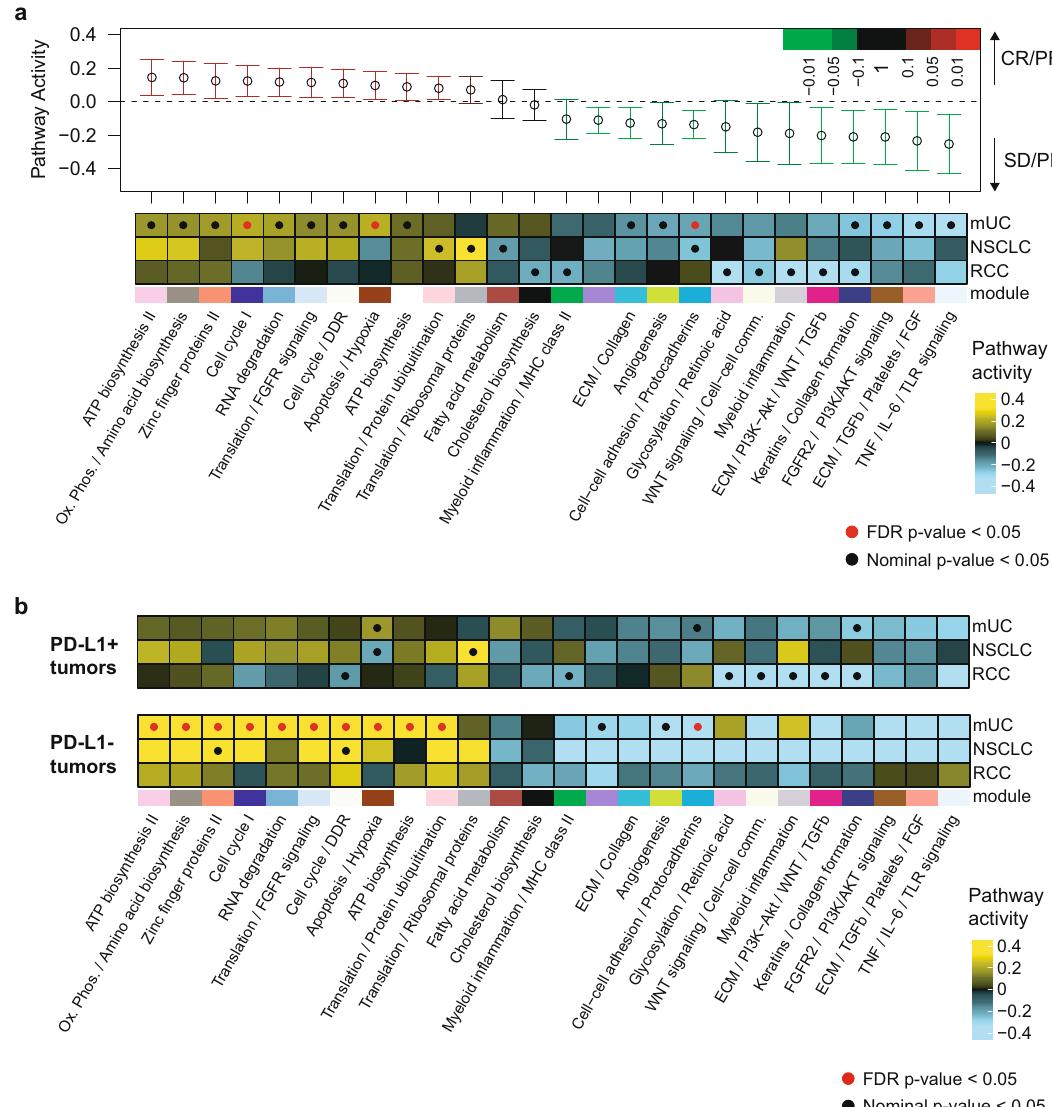
Fig. 3 Transcriptional correlates of response to PD-L1 blockade across indications. a In all tumors combined. Upper panel, Forest plot representing the pathway activity of WGCNA modules signi fi cantly enriched by Q-Gen analysis between responders and nonresponders across the combined cohorts or on an individual cohort basis. The pathway-level model contrasts responders and nonresponders, including indication as a covariate in the cross-indication analysis. The 20 modules detected as signi fi cant ( p < 0.05) in any of the four models conducted are included in the display. Modules are ordered from left to right according to pathway activity across indications. Error bars represent the 95% con fi dence interval. Lower panel, heatmap representing per- indication pathway activity for modules selected from the combined cross-indication and per-indication analyses. Module enrichment signi fi cance is highlighted as a red dot (FDR-corrected p < 0.05) or a black dot (nominal p < 0.05). n = 208 mUC, n = 81 NSCLC, and n = 77 RCC biologically independent samples were examined. b Same as a for PD-L1 + (upper heatmap) and PD-L1 − (lower heatmap) tumors